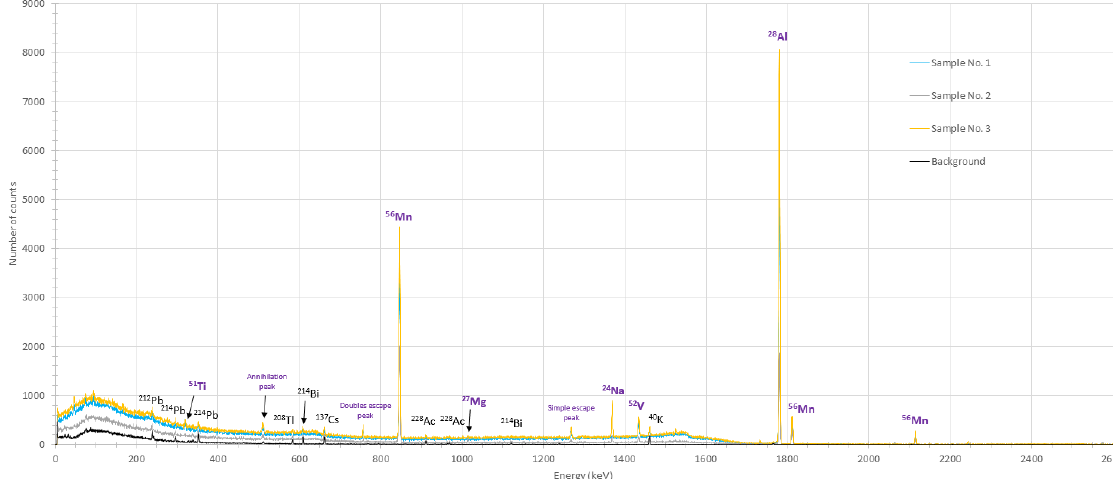
Fig. 8. On the left: irradiation step (neutron cell in open position). On the right: gamma-ray spectrometry detection step with an HPGe detector. Fig. 4. Delayed gamma-ray spectrum of the background.